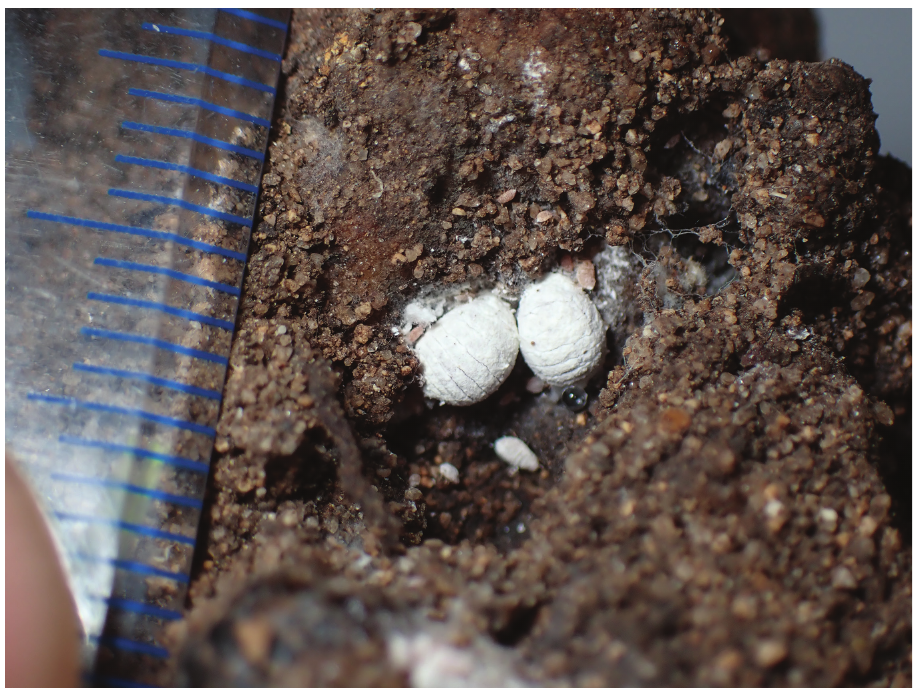
Figure 2. Live mature adult females of Formicoccus yoshinoi Tanaka, sp.